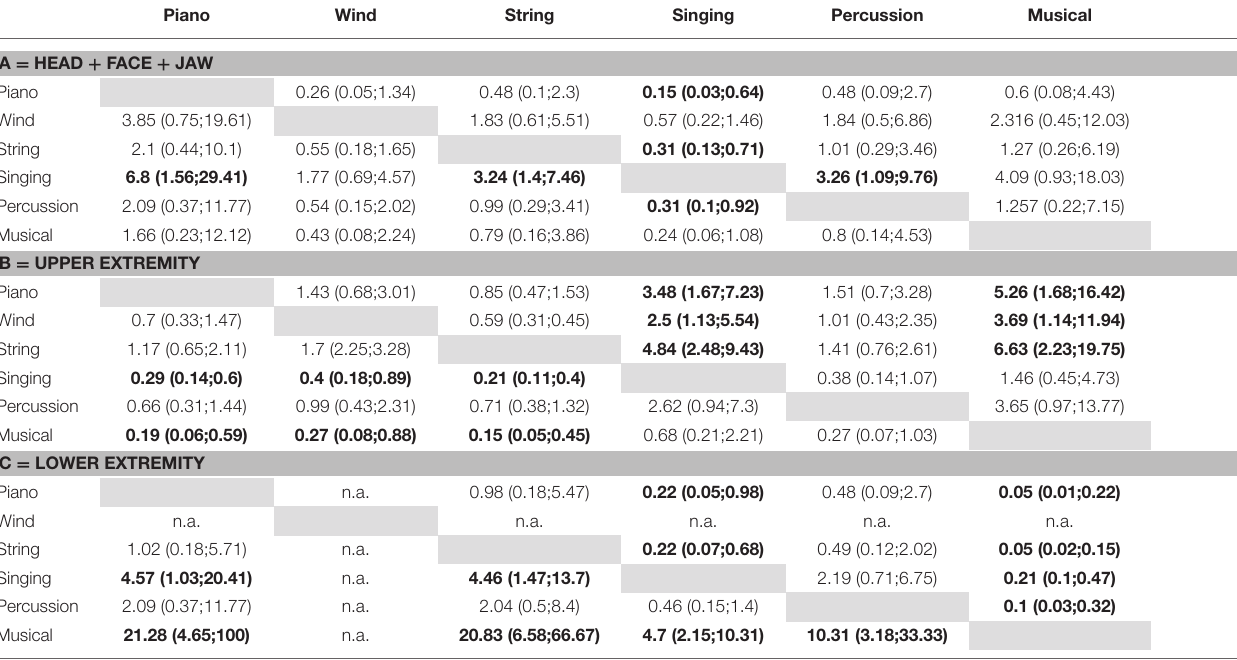
TABLE 3 | Odds ratios of experiencing complaints compared between IGSD based on logistic regression.